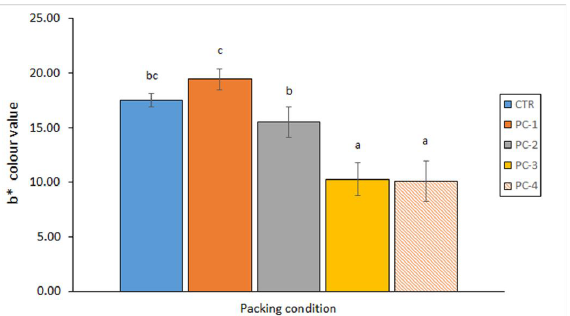
Figure 1. Determination of the b* colour value in canned mackerel ( S. scombrus ) packed under different conditions. Average values accompanied by different letters denote significant differences ( p < 0.05). Sample abbreviations: CTR, PC-1, PC-2, PC-3 and PC-4 correspond to packing conditions including 0.000, 0.125, 0.250, 0.625 and 1.250 g of extracted alga in the packing medium, respectively. Adapted from Barbosa et al. [74].